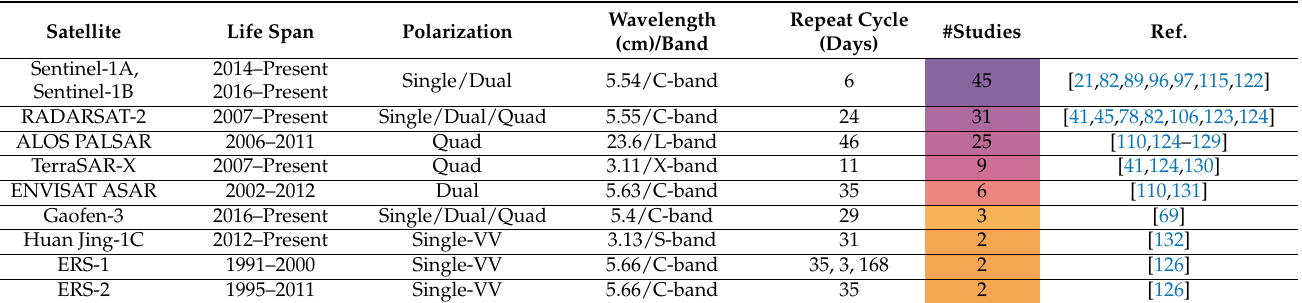
Table 5. List of the commonly used optical satellites in wetland studies ranked by the number of times they have been utilized in the papers.